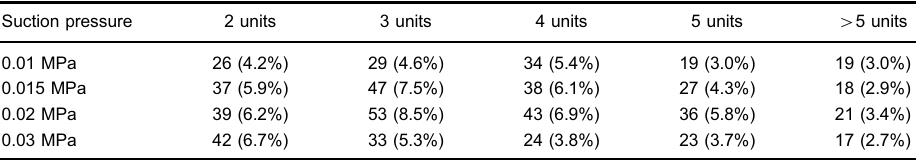
Table 2. Subjects were assigned to different number of transfusion units and pressures of intraoperative salvage autotransfusion.